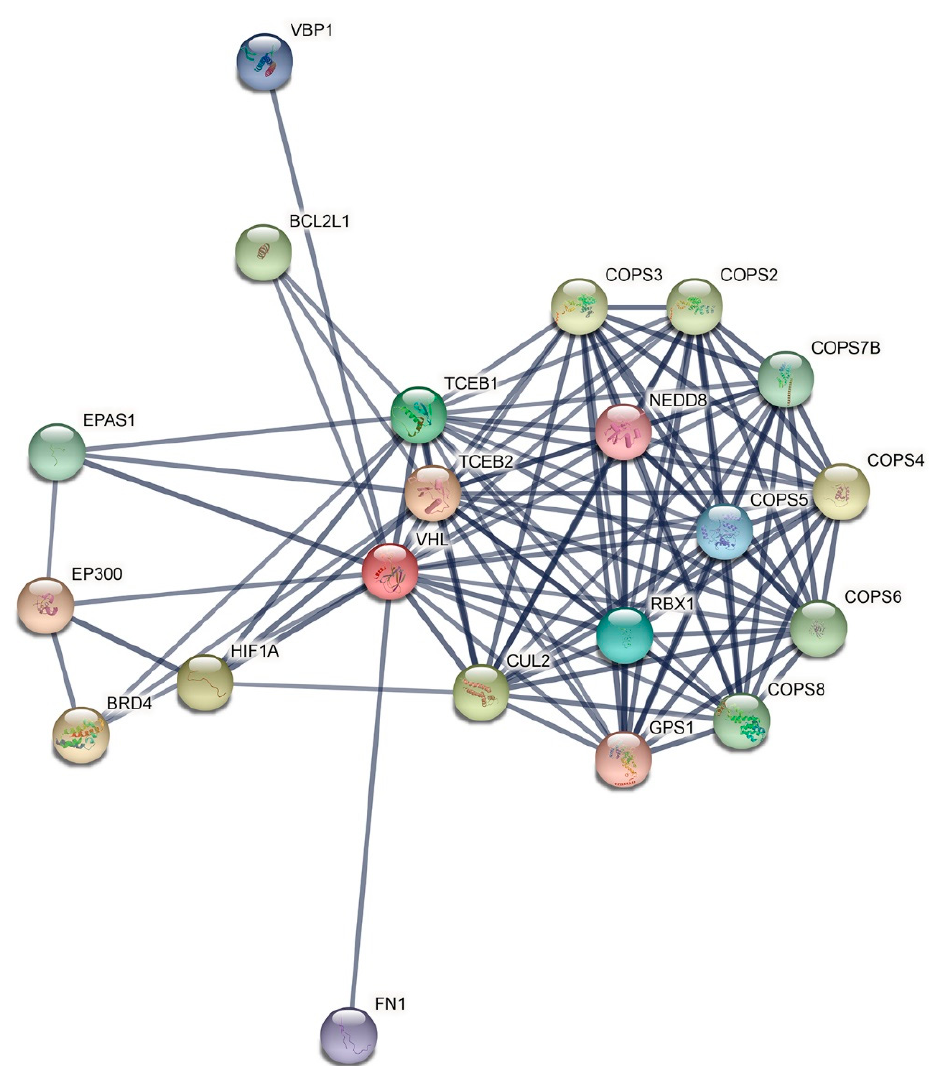
Figure 3. STRING network of VHL protein–protein interactions. Settings: Network type, full STRING network; meaning of network edges, confidence (line thickness indicates the strength of data support); active interaction sources, experiments; minimum required interaction score, high confidence (0.700); max number of interactors to show, no more than 20 interactors; organism, Homo sapiens [78].